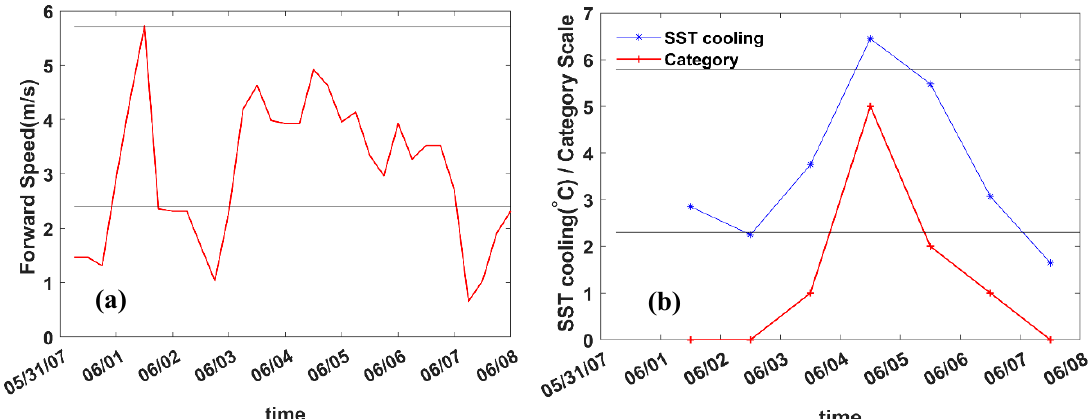
Figure 3. ( a ) Timseries of Gonu’s forward speed, 1–7 June. ( b ) Timseries of maximum SST cooling from 1–7 June (blue), and the corresponding timeseries of cyclone intensity (red). In panel ( a ), the horizontal black lines show the forward speed threshold for a slow- and medium-moving storm based on Bender et al. [1].The horizontal black lines in panel ( b ) show the SST cooling corresponding to slow- and medium-moving storm based on Bender et al. [1].